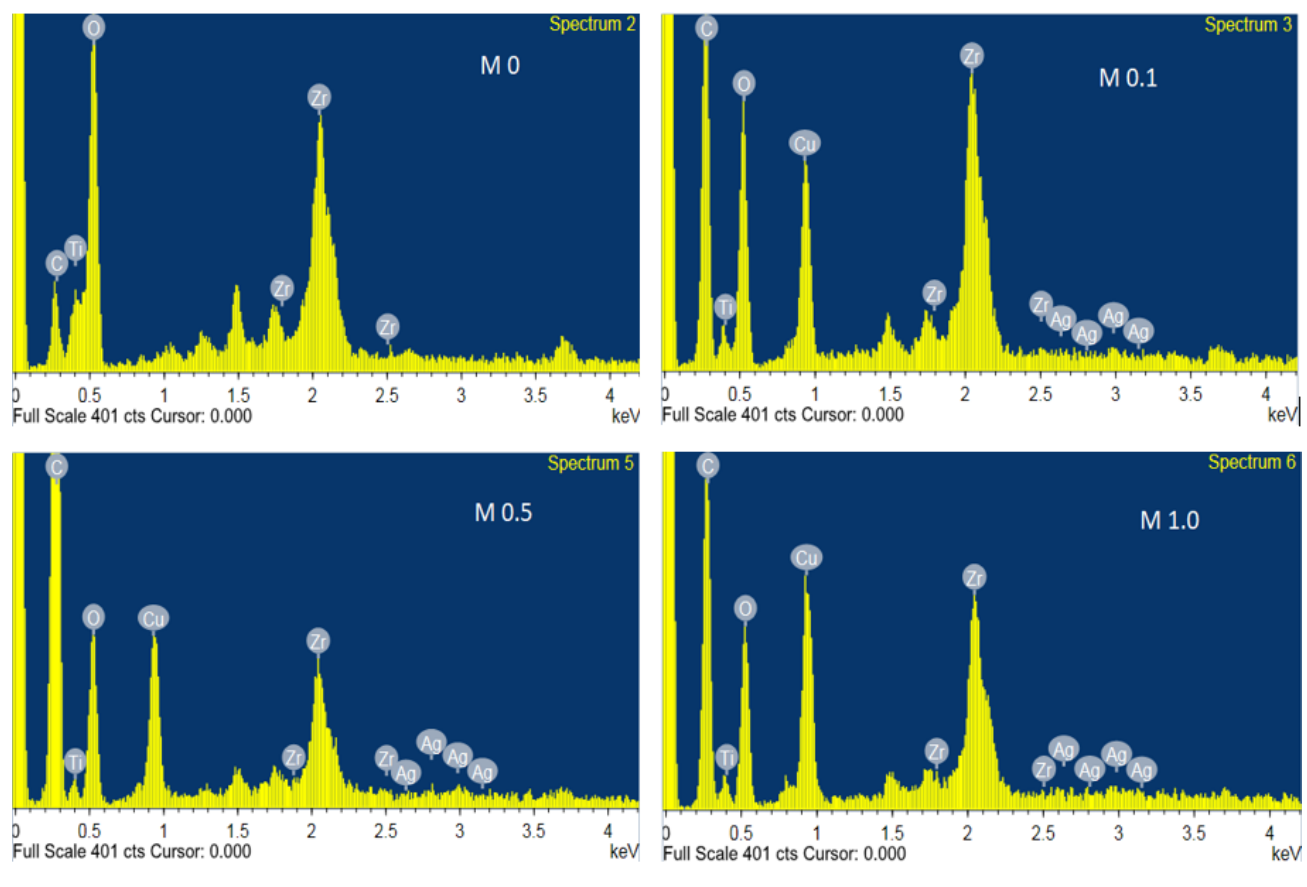
Figure 5. EDX spectra of pristine and coated membranes.